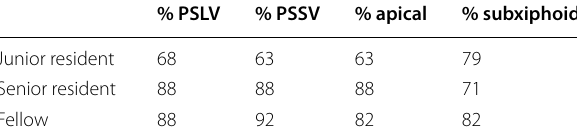
Table 2 Basic cardiac window obtained by level of training